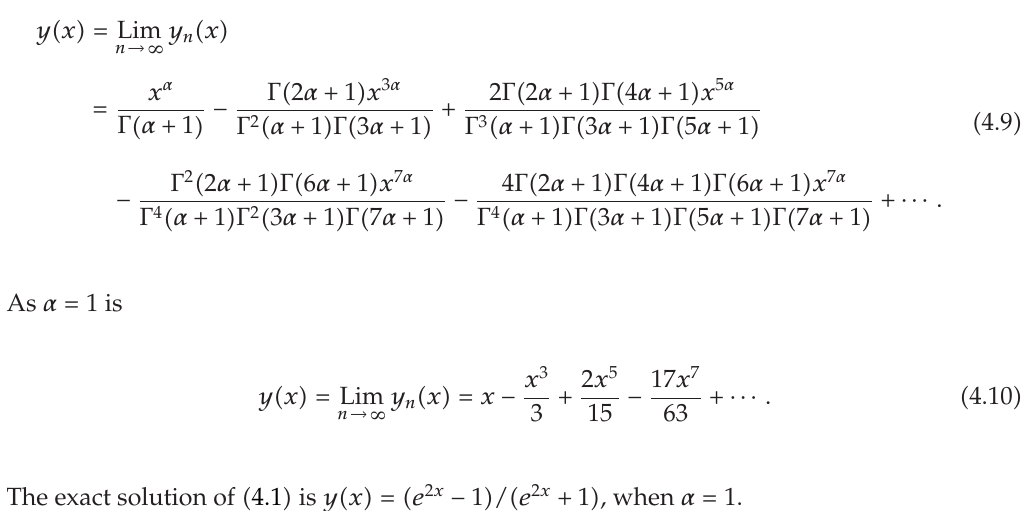
Figure 1 indicates the solution obtained using FVIM versus the exact solution when α (cid:7) 1. Figure 2 is plotted for approximate solution of time-fractional Riccati di ff